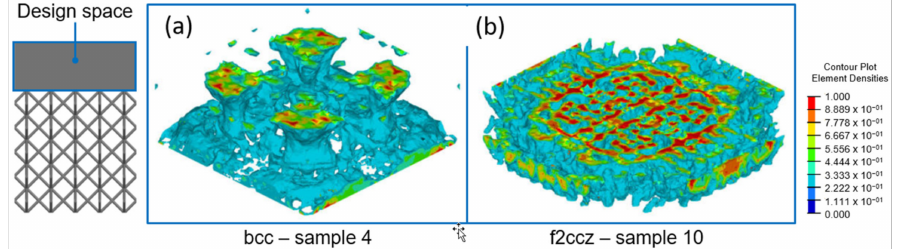
Figure 9. Optimised design space—bcc sample 4 ( a ) and f2ccz sample 10 ( b